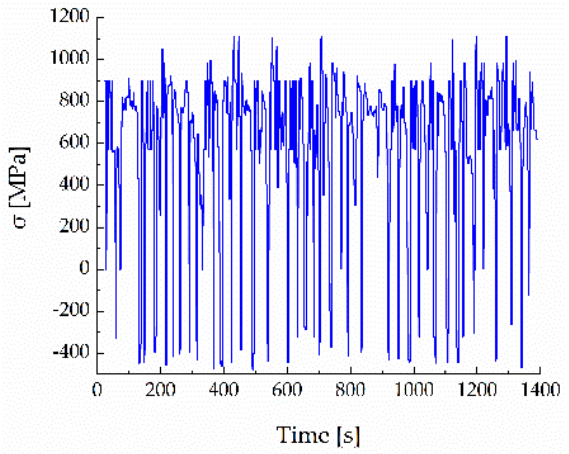
Figure 10. Contact stress load spectrum of electromagnetic braking.